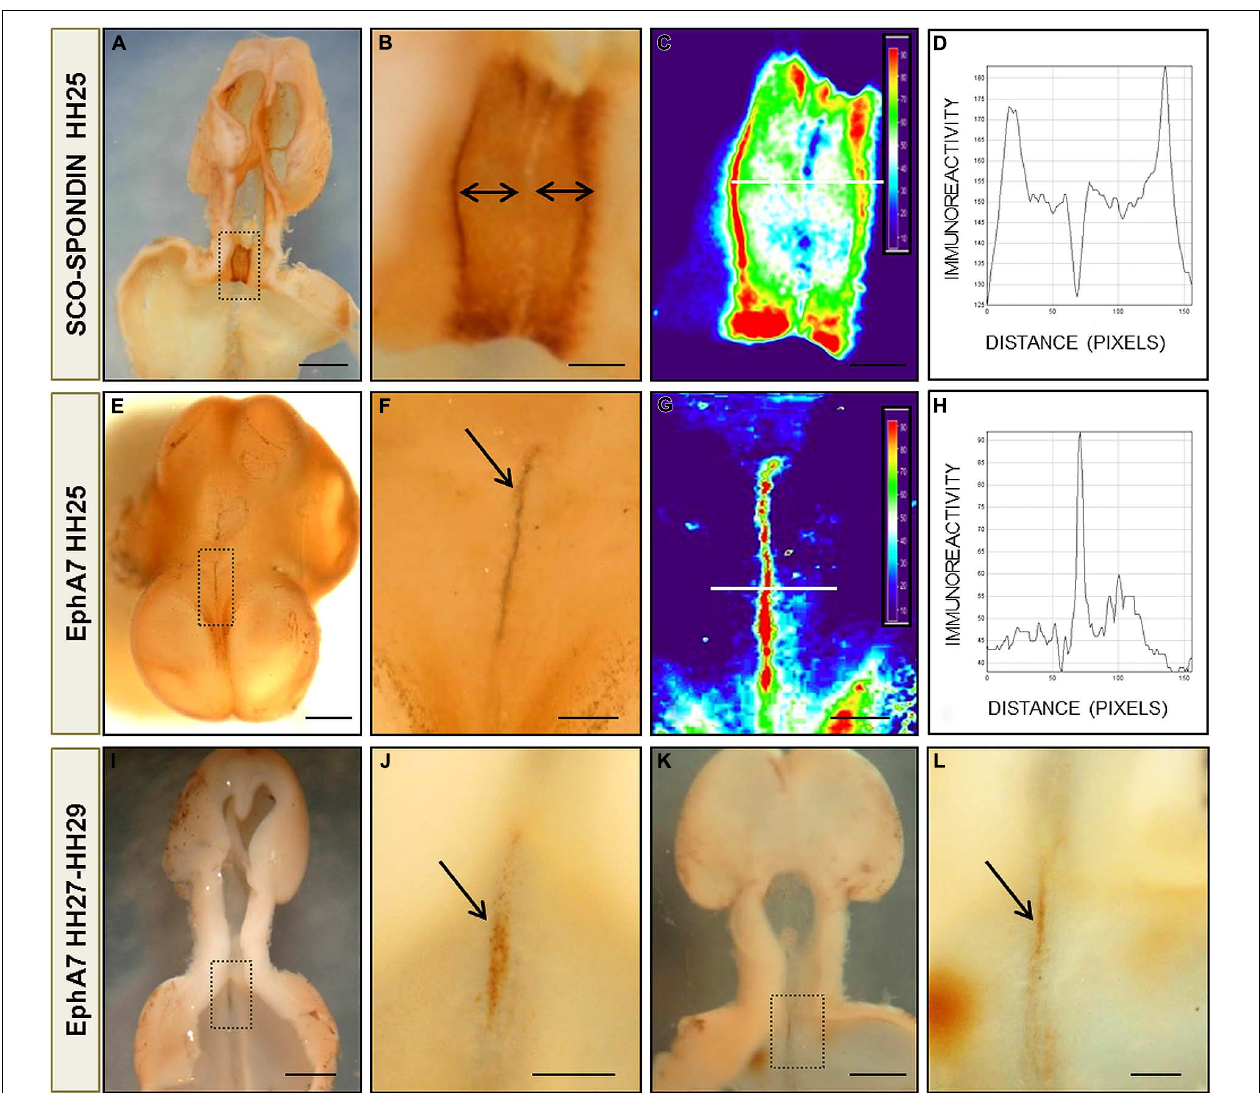
FIGURE 4 | Protein pattern expression of EphA7 and SCO-spondin during chick brain development. (A,B,E,F) Whole mount immunohistochemistry for SCO-spondin (A,B) and EphA7 (E,F) of HH25 chick brain embryos showing the complementarity expression between the labeling of SCO-spondin and EphA7 in the diencephalic roof plate (arrows in B,F ). (C,G) Pseudocolor images of (B,F) showing the expression level of SCO-spondin and EphA7, respectively. The intensity